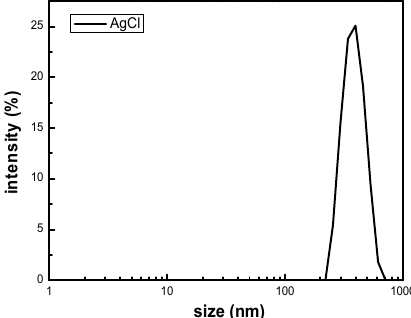
Figure 2. Dynamic particle size distribution of AgCl NPs.